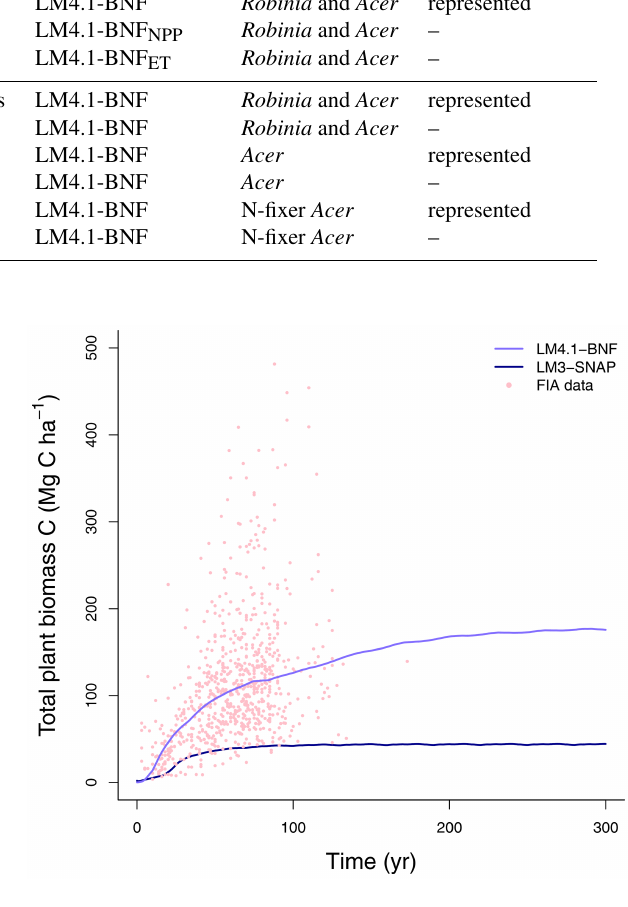
Figure 5. Simulated total plant biomass C over time by LM4.1- BNF and LM3-SNAP compared to FIA data (in North Carolina). Each point represents an FIA